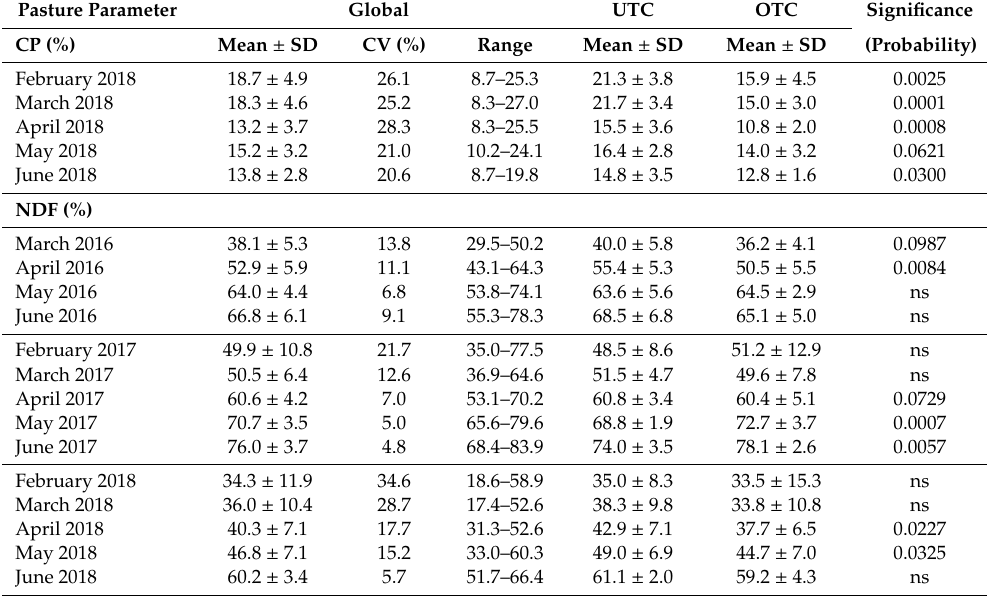
Pasture Parameter